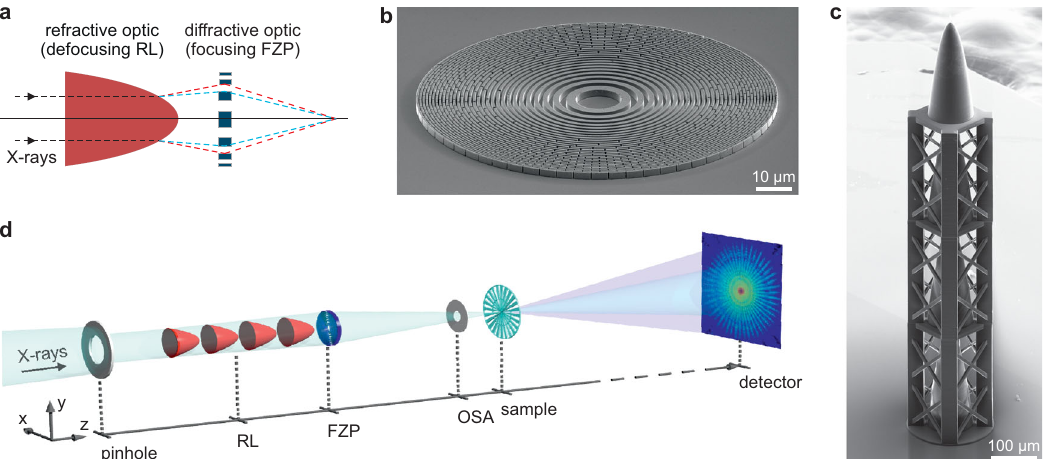
Fig. 1 Concept of the X-ray achromat and experimental setup. a Principle of achromatic focusing: The chromaticity of the defocusing refractive lens (RL) acts as a corrector for the chromatic behaviour of the focusing Fresnel zone plate (FZP). b Scanning electron microscopy (SEM) image of a nickel FZP fabricated by electron-beam lithography and nickel electroplating, as used for the comparison measurements. c SEM image of the RL consisting of four stacked paraboloids 3D-printed using two-photon polymerisation lithography. d Sketch of the experimental setup for scanning transmission X-ray microscopy (STXM) and ptychography using the achromat as a focusing optic.